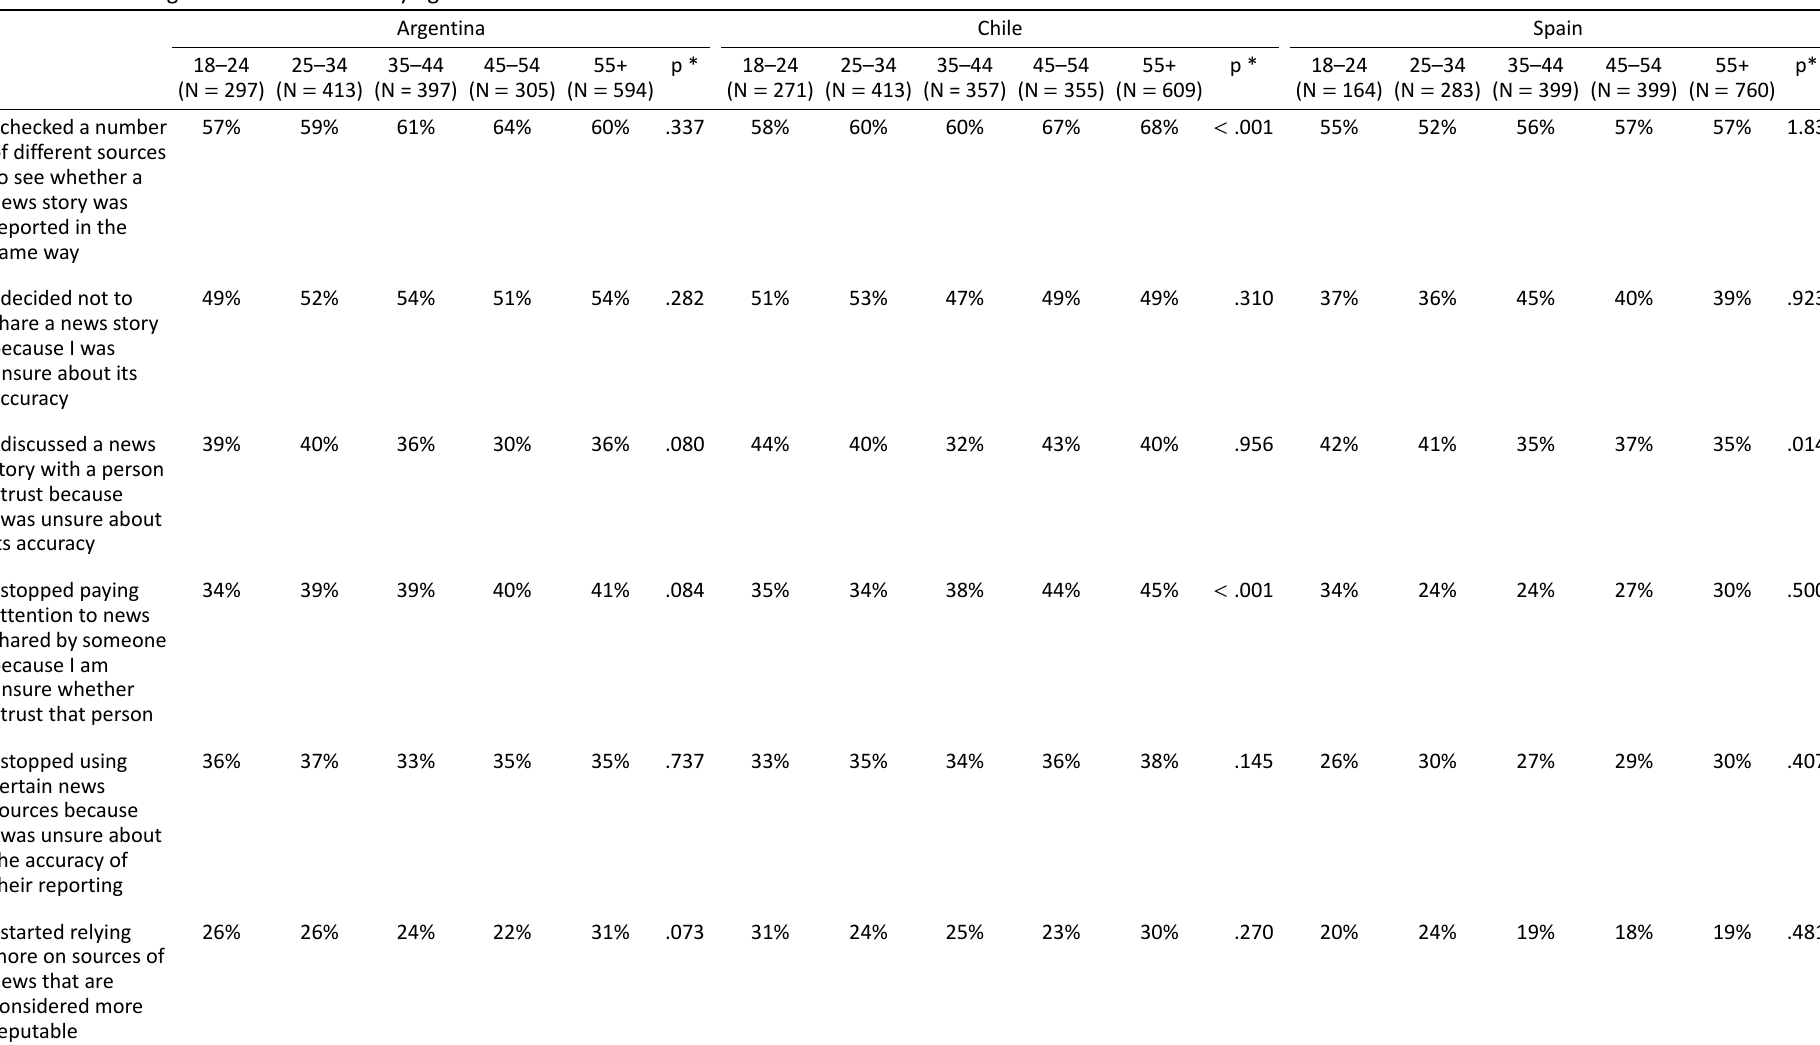
Table 6. Actions against disinformation by